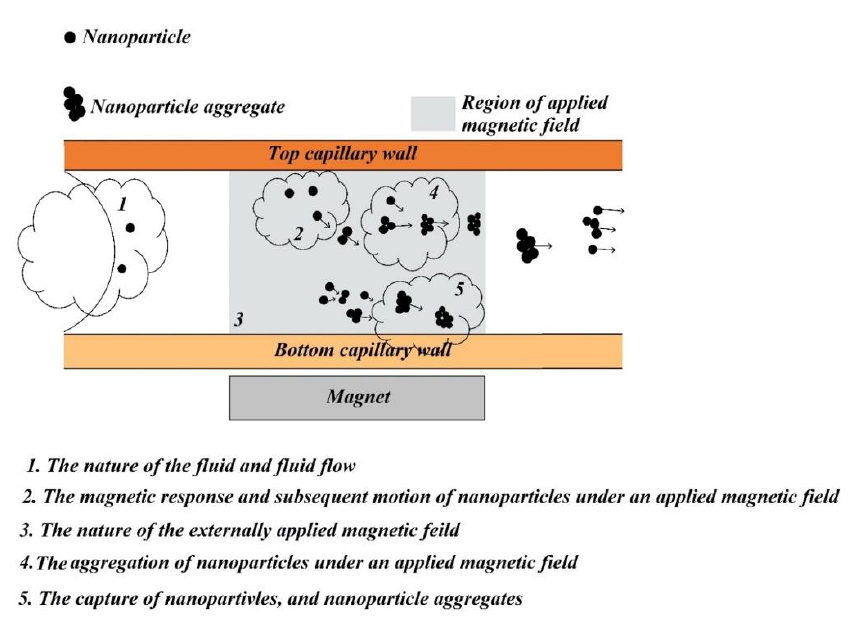
Figure 8. Effect of the magnetic field on nanoparticle accumulation in nanofluid [188].